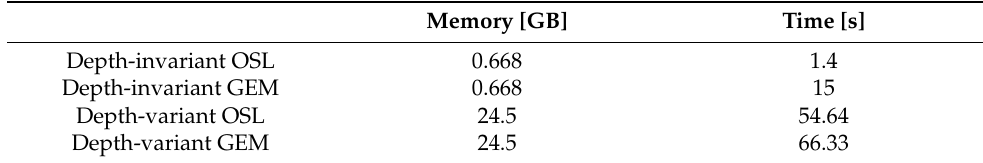
Table 3. Memory requirements and processing